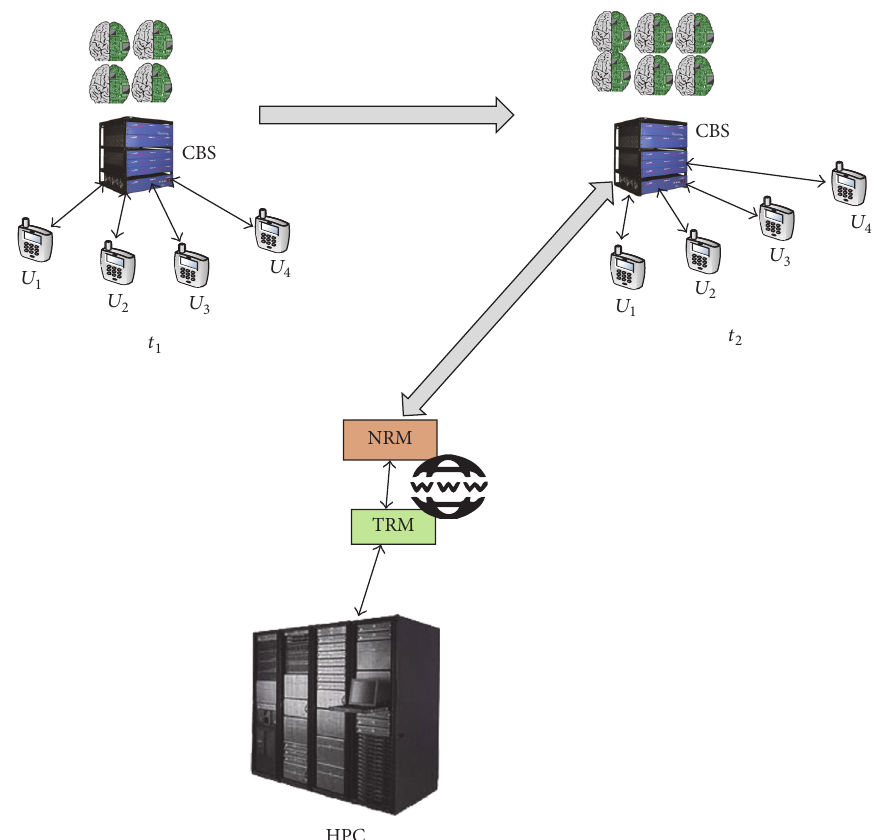
Figure 6: Evolution of states of artificial neural network multiuser detectors at epochs 𝑡 1 and 𝑡 2